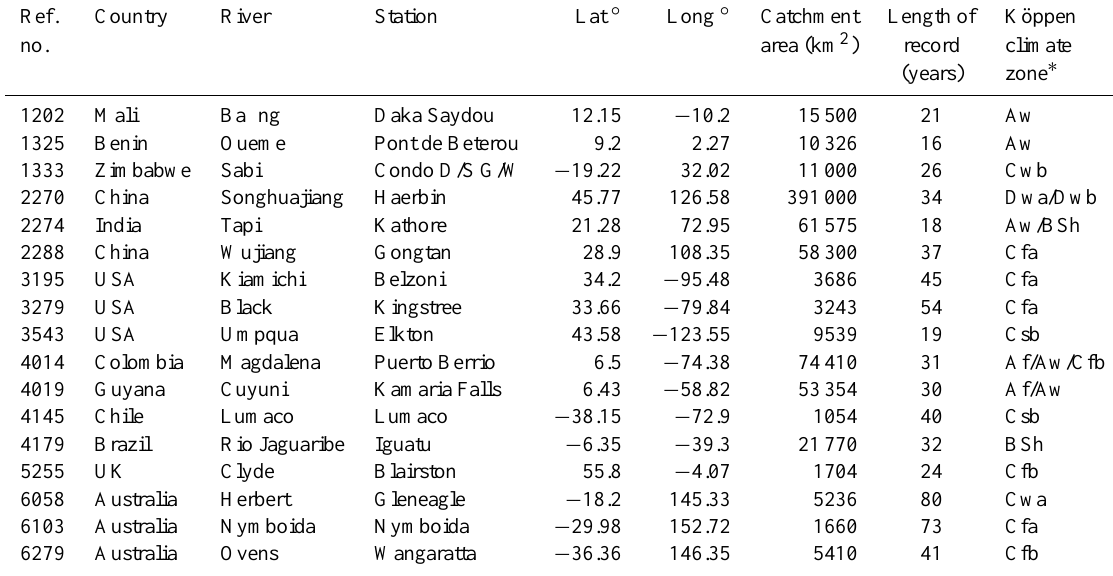
Table 3. Details of the 17 selected catchments. Ref. Country River Station Long ◦ Length of Köppen no. area (km 2